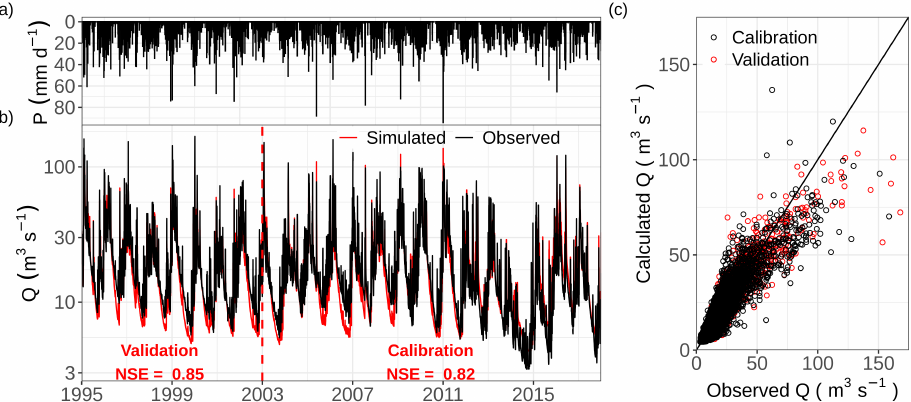
Figure 6. ( a ) Basin-averaged daily precipitation, in mm d − 1 . ( b ) Simulated (red line) and observed (black line) discharges, in m 3 s − 1 , with y -axis in log scale. Vertical dashed line separates calibration from validation, and labels show the NSE index. ( c ) Scatter plot of observed and calculated discharges, for calibration (black circles) and validation (red circles)